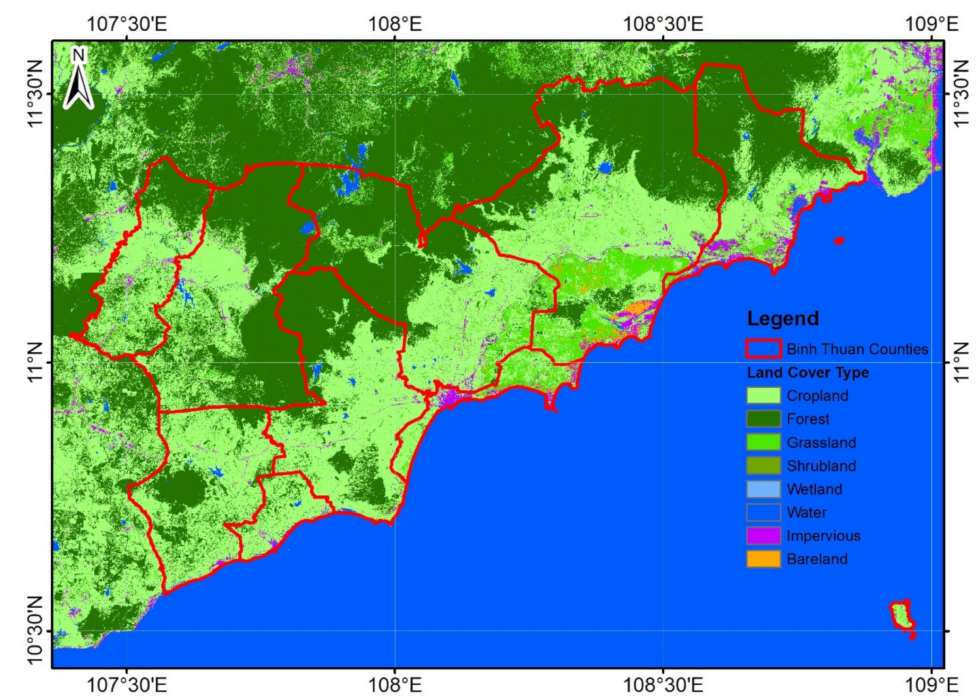
Figure 13. Land cover types of Binh Thuan Province in 2017.